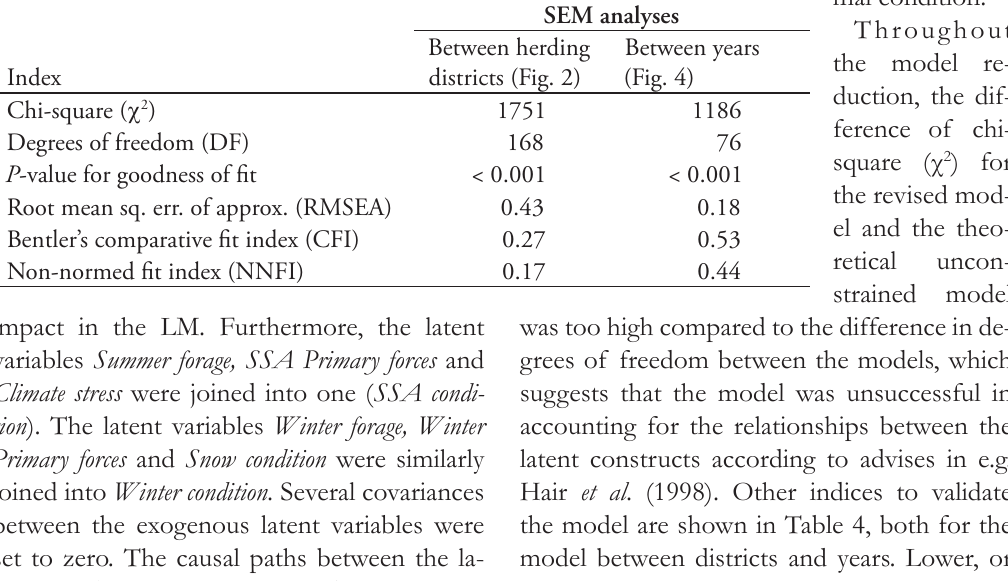
Table 4. Goodness-of-fit indices for the final structural equation models describing between-district and between-year variations. For definitions of fit indices, see SAS Statistical Software (SAS Institute Inc.,